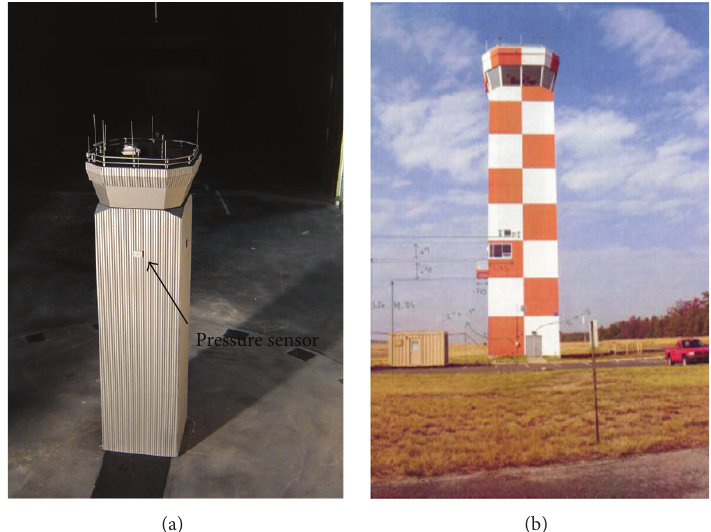
Figure 4: (a) Wind tunnel model of the RALS tower [7] and (b) actual image of the RALS